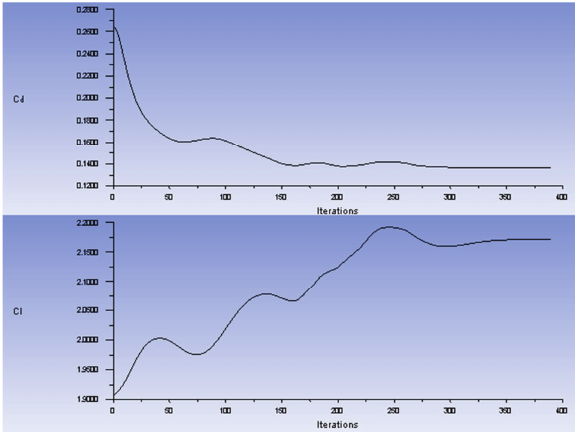
Fig. 5. Convergence of drag and lift coefficient